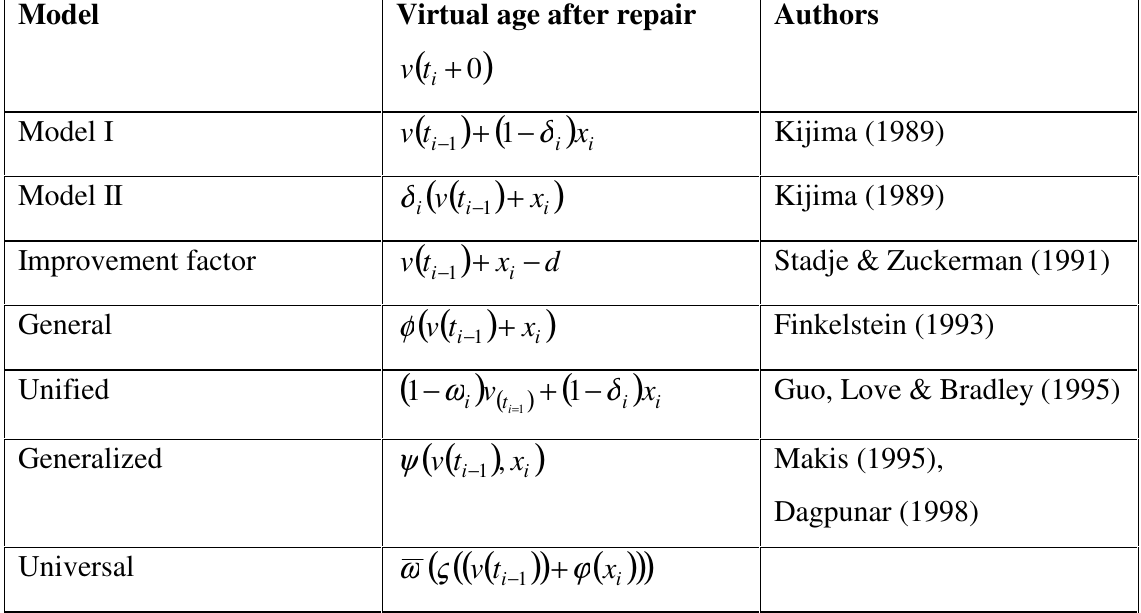
Table 4: Virtual age